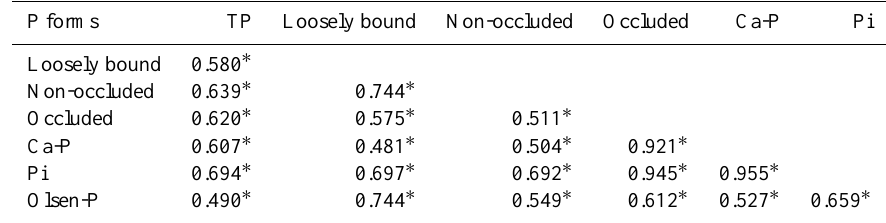
Table 2. Correlations (Pearson’s coefficient, n = 30) among the P forms. P forms